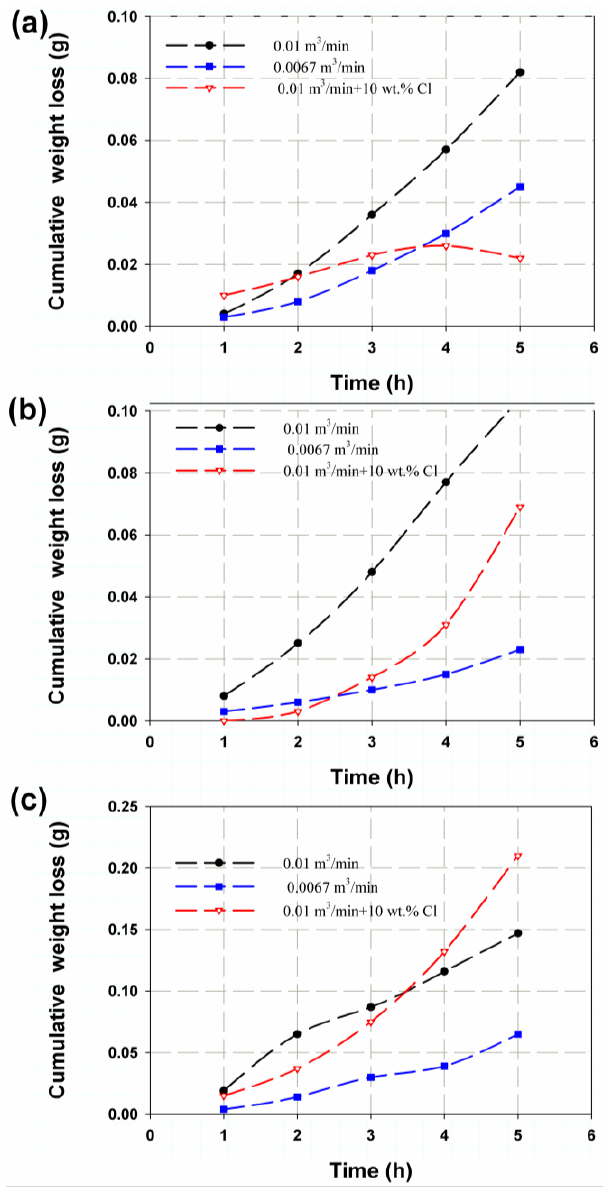
Figure 4. Cumulative weight loss versus time for ( a ) 250 g, ( b ) 400 g and ( c ) 500 g of sand mass.